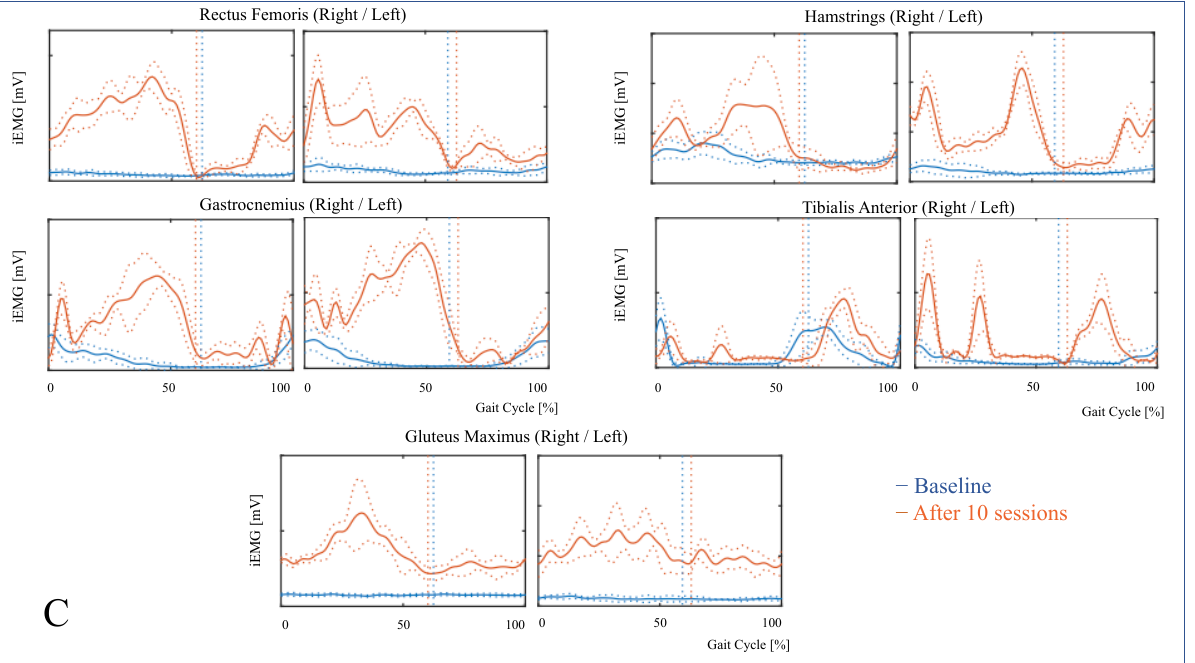
Figure 2. ( A ) Temporal profile of the angular position of the hip, knee, and ankle joints over the gait cycle, measured without the hybrid assistive limb (HAL) before session 1 (baseline) and after all 10 HAL training sessions. Vertical lines indicate the moment of toe lift. ( B ) Standard deviations from the average of the hip, knee, and ankle joint and pelvic angles. ( C ) Muscle activities of the rectus femoris, hamstrings, gastrocnemius, tibialis anterior, and gluteus maximus without the hybrid assistive limb (HAL) before session 1 (baseline) and after all 10 HAL training sessions. Each muscle response is activated during the gait cycle. The gastrocnemius muscles show greater response at the baseline than after 10 sessions, from the initial to the terminal during the stance phase. Vertical lines indicate the moment of toe